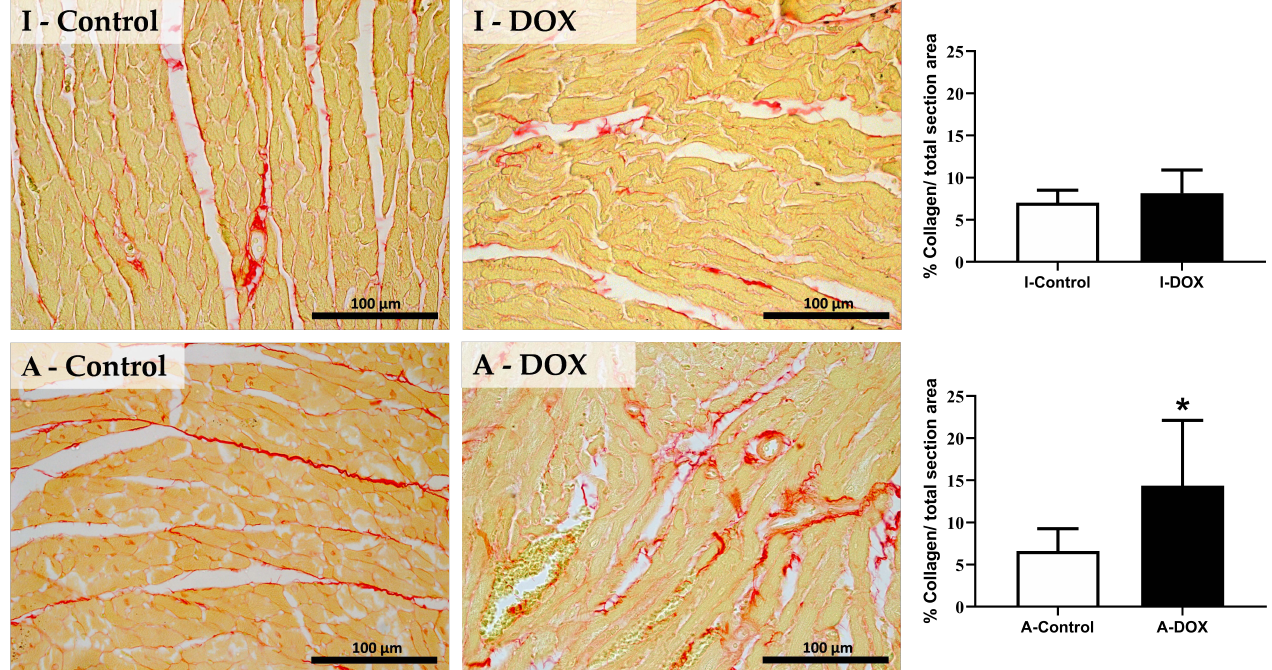
Figure 4. Sirius red staining assessed by light microscopy and semi-quantitative analysis of fibrosis in the heart of infant DOX-treated ( I-DOX ) and control mice ( I-Control ), and adult mice exposed to a cumulative dose of 18.0 mg/kg DOX ( A-DOX ) and respective controls ( A-Control ). Images were taken at 40 × magnification. Scale bar = 100 µ m. The results of collagen content red staining are expressed as a percentage of collagen per total section area. Statistical comparisons were made using the Mann–Whitney test: * p < 0.05, DOX vs. control.